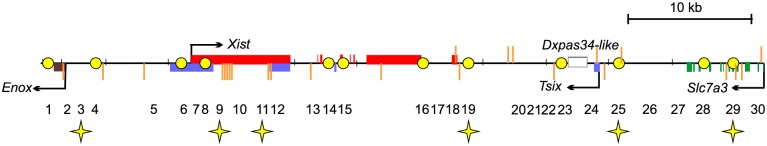
Location of G4 motifs in the XIC locus.Schematic representation of XIC locus of M. levis and G4 motifs localizations. Exons are indicated by rectangles. Arrows show direction of transcription. Vertical lines show locations of G4 motifs. G4 motifs on the sense strand (according to Xist transcription) are shown above, G4 motifs on the antisense strand are shown below. Stars indicate regions containing active origins in all cell lines analyzed and circles do regions of ORC binding.